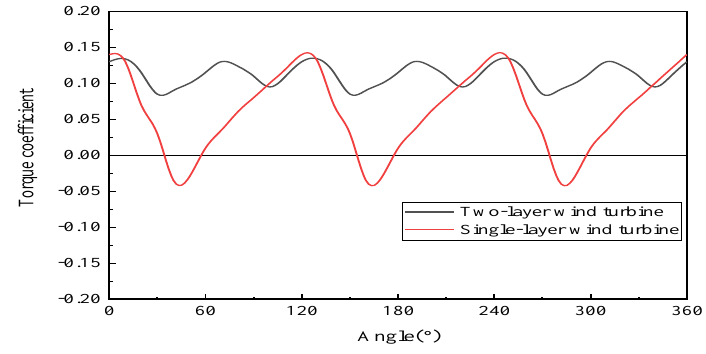
Figure 15. Torque coefficient comparison curves of the three blades.